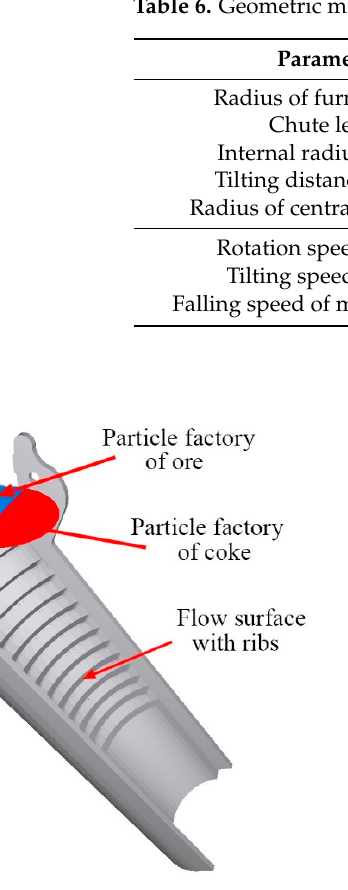
Figure 4. Process of particles from generation to falling to the burden surface: ( a ) burden generation model; ( b ) charging system.